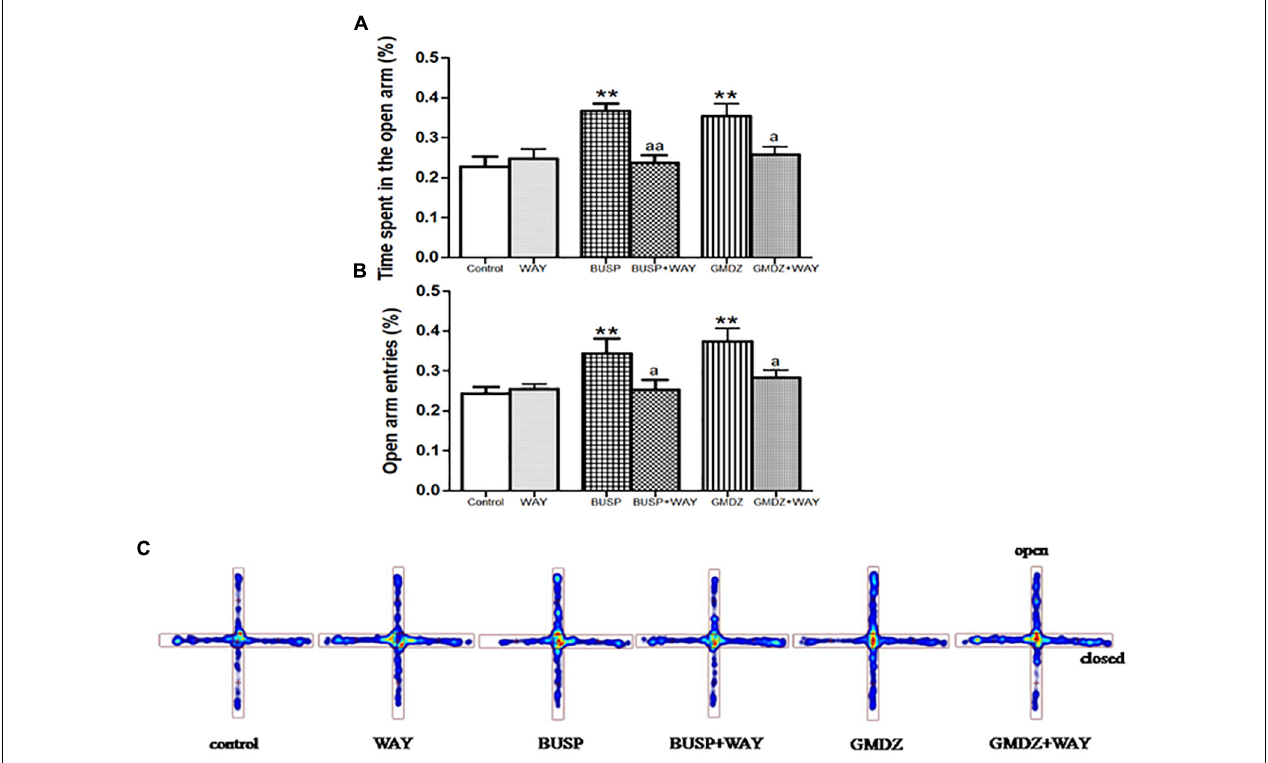
FIGURE 4 | Effects of receptor antagonists on anxiolytic-like effect of GMDZ in EPM test. (A) Effect of WAY on the percentage of time spent in open arms. (B) Effect of WAY on the percent of open arms entries. (C) Representative heat map analysis of one animal in each group. Value are represented as mean ± SEM ( n = 12). ∗∗ P < 0.01 vs. control group; a P < 0.05 or aa P < 0.01 treatment vs. antagonist (interaction effect). Two-way ANOVA with Bonferroni post hoc